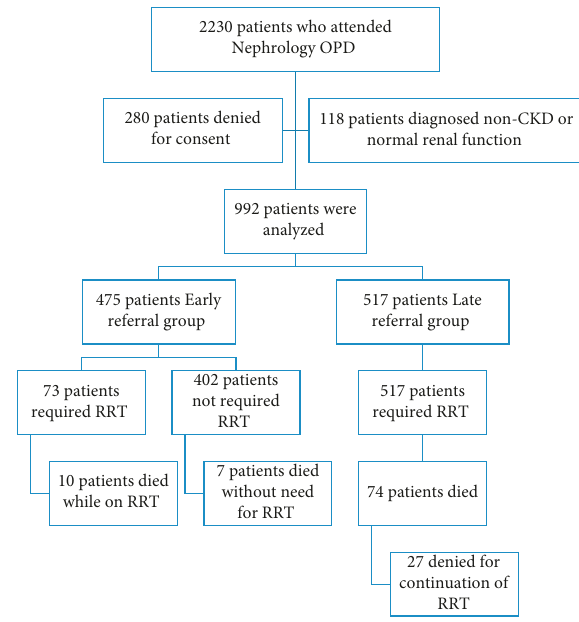
Figure 1: Consort diagram of study